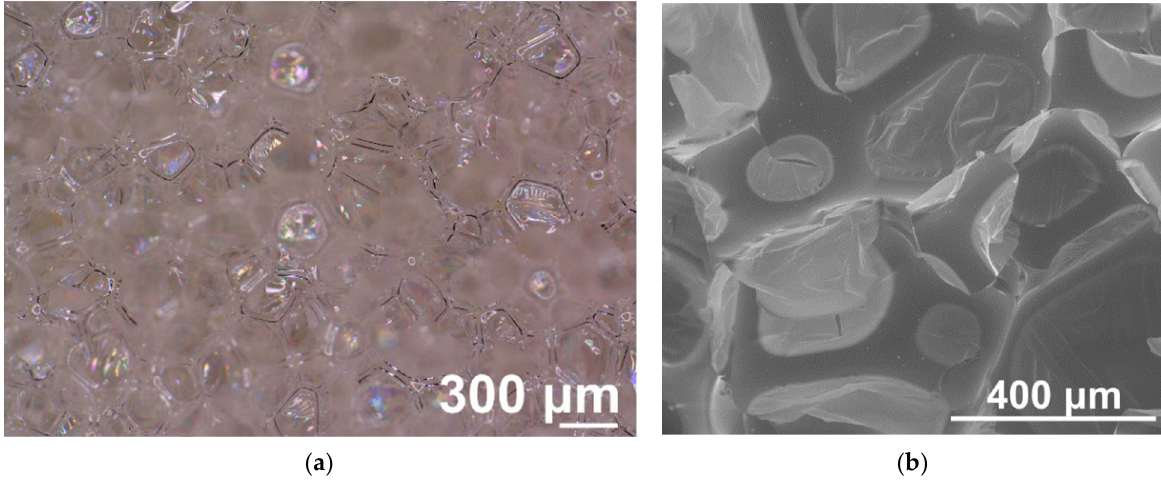
Figure 3. Optical ( a ) and SEM image (b ) of the cross-sections of PUR foam. Magnitudes ×100 ( a ), and ×200 ( b ). Strut thickness (Table 2) of the cells was approximately 20 µ m, vertical and horizontal Feret diameters were 193 and 207 µ m. The similarity in both Feret diameters values indicated no favorable growth direction within the cross-sectional area of the sample. SEM image (Figure 3b) shows minor disruption of the cellular structure caused by the coating with the gold process. Table 2. PUR cellular morphology parameters.